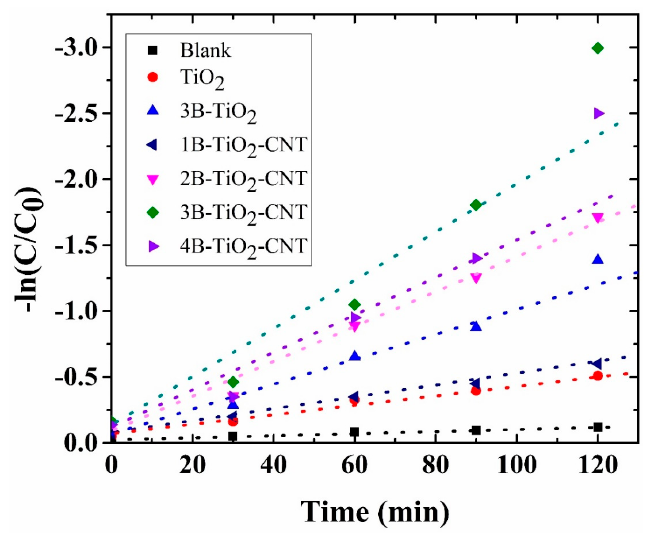
Figure 7. The pseudo-first-order kinetics of degradation of toluene gas with a time of UV light irradiation.